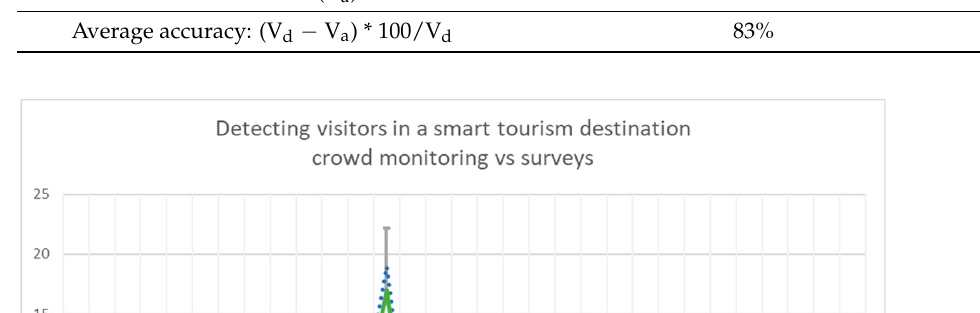
Figure 7. Using HOPU Smart Spot vs. manually conducted surveys to determine number of visitors in Alcoi.